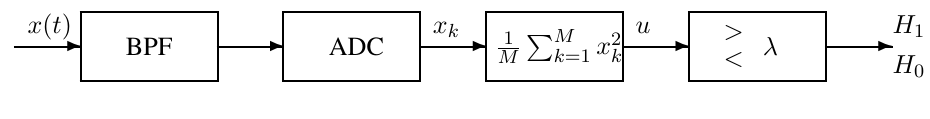
Figure 1. Block diagram of an energy